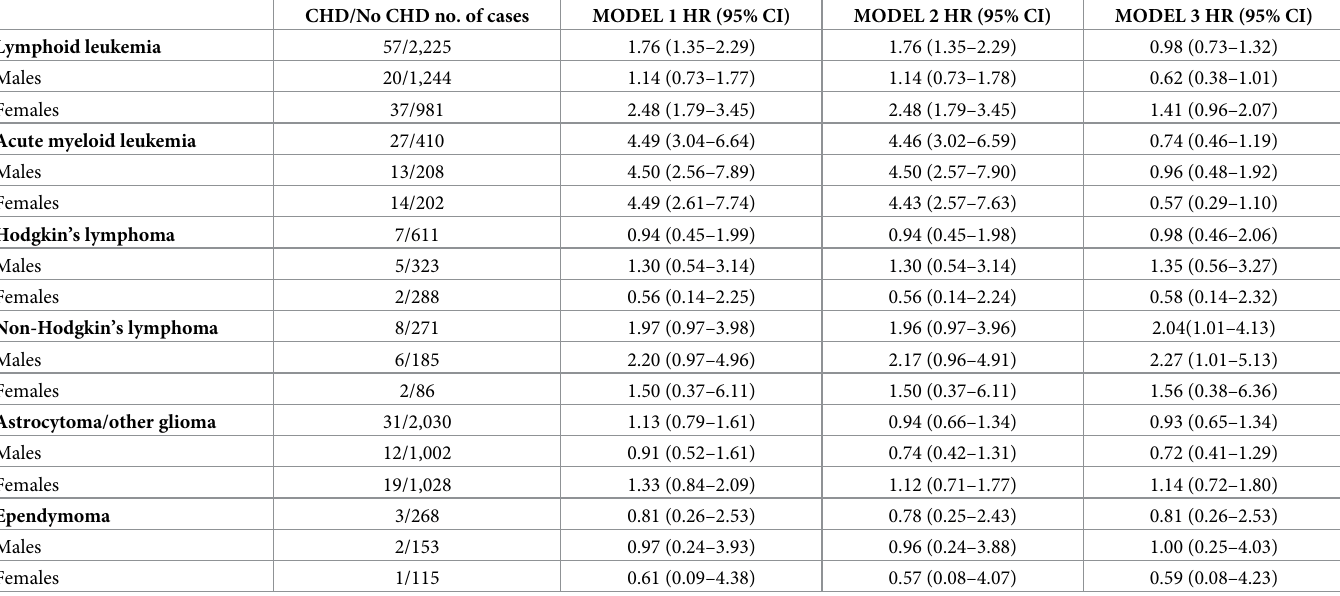
Table 4. Adjusted HRs (95% CIs) of leukemia, lymphoma, and CNS cancer subtypes in children with CHD.